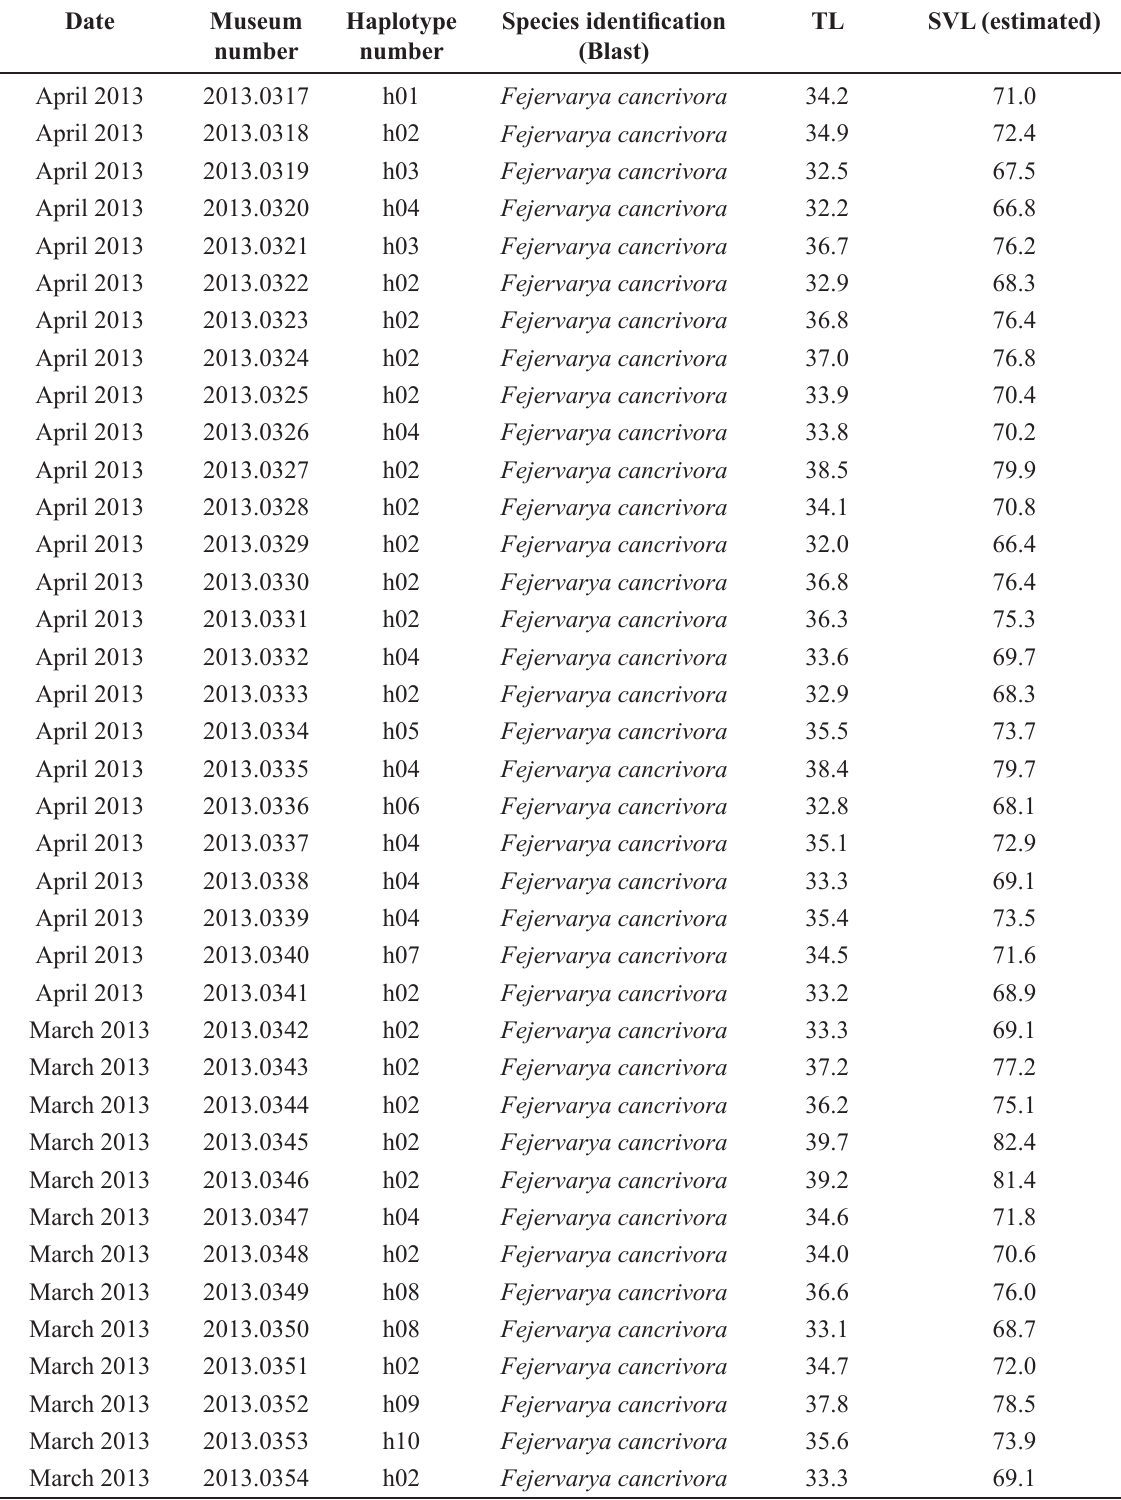
List of samples of deep frozen frog legs with purchase date, collection number, haplotype number, taxonomic identification, tibia length (TL) and estimated snout vent length